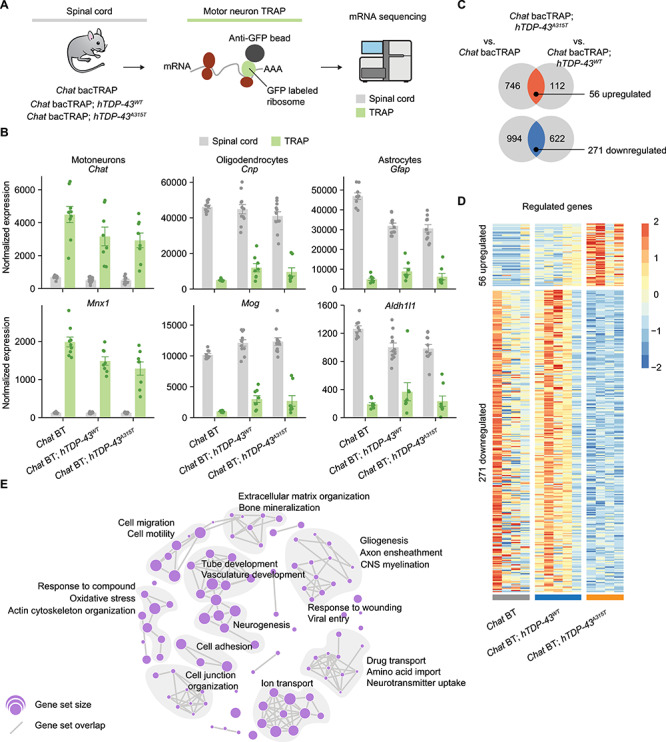
Screening of the motor neuronal translatome of hTDP-43A315T ALS mice after motor symptom onset. (A) Overview of the MN-TRAP experiment from three different genotypes: Chat bacTRAP, Chat bacTRAP; hTDP-43A315T, and Chat bacTRAP; hTDP-43WT. (B) Relative enrichment of MN genes (Chat and Mnx1) and de-enrichment of genes expressed in oligodendrocytes (Cnp and Mog) and astrocytes (Gfap and Aldh1l1) by MN-TRAP. Mean values ± SEM are shown. (C) Identification of differentially expressed (DE) genes in the MN translatome at 14 weeks. The Venn diagrams indicate the number of DE genes in the MN translatome of Chat bacTRAP; hTDP-43A315T mice in comparison to Chat bacTRAP and Chat bacTRAP; hTDP-43WT mice at 14 weeks, 56 upregulated and 271 downregulated genes were found to be exclusively deregulated in the Chat bacTRAP; hTDP-43A315T mice at 14 weeks. (D) Heatmap of genes found to be deregulated in Chat bacTRAP; hTDP-43A315T mice at 14 weeks. (E) Enrichment map of biological process GO terms. Node size represents gene set size, edges connect similar gene sets. Chat BT, Chat bacTRAP.